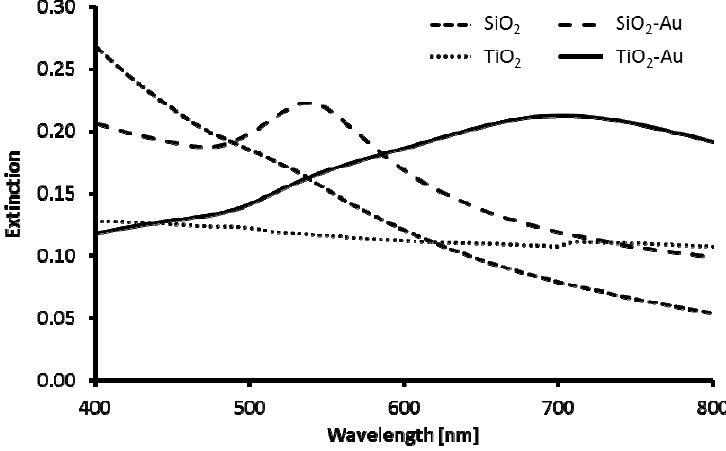
Figure 3. UV-Vis spectra of silicon dioxide and titanium dioxide cores before and after deposition of Turkevich